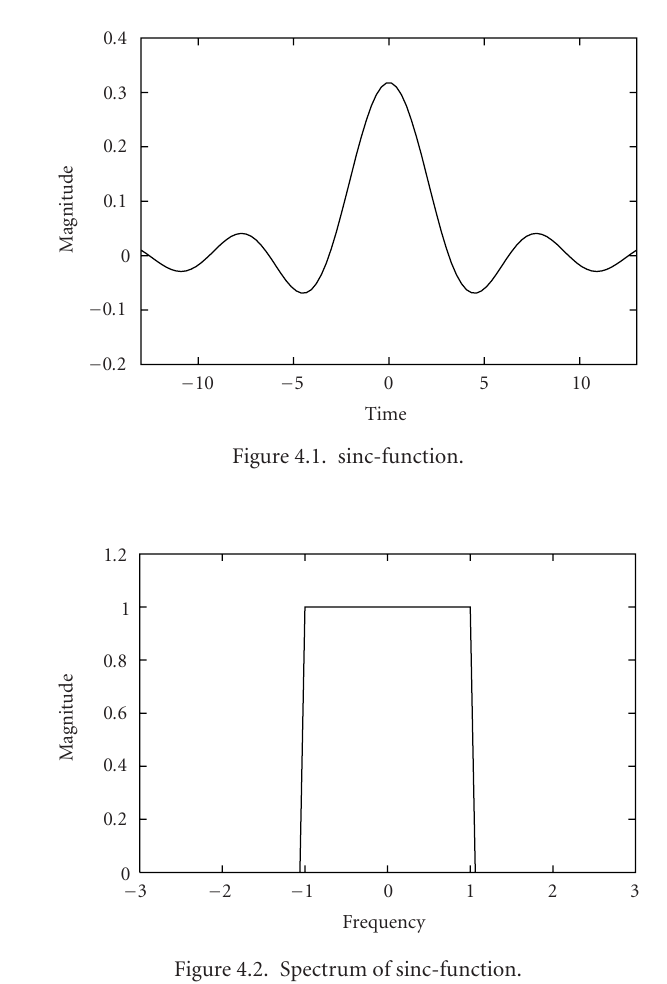
Figure 4.2. Spectrum of